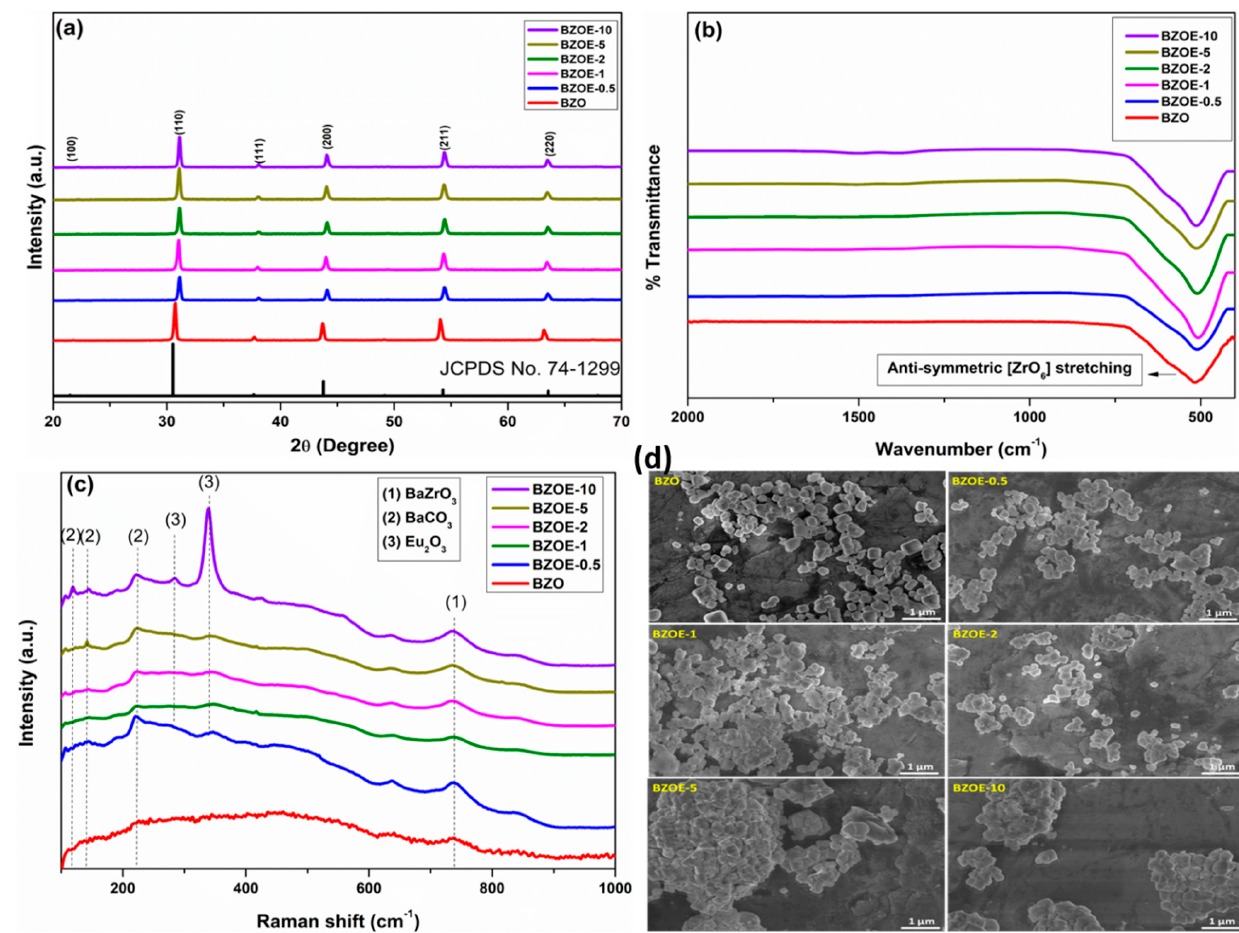
Figure 1. ( a ) XRD patterns, ( b ) FTIR spectra, ( c ) Raman spectra, and ( d ) SEM images of the BZO and BZOE samples. Table 1. Lattice constants and crystallite sizes of the BZOE obtained from Rietveld refinement of the XRD data shown in Figure 1a .